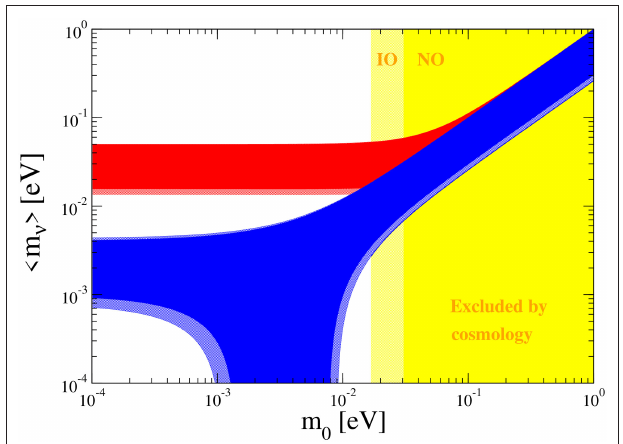
FIGURE 1 | Predictions on h m ν i from neutrino oscillations vs. the lightest neutrino mass m 0 in the two cases of normal (the blue region) and inverted (the red region) spectra. The 2 σ and 3 σ values of neutrino oscillation parameters are considered [21]. The excluded region by cosmological data ( 6 m ν < 0.12 eV) m 0 is presented in yellow ( > 30 meV for the NO and > 16 meV for the